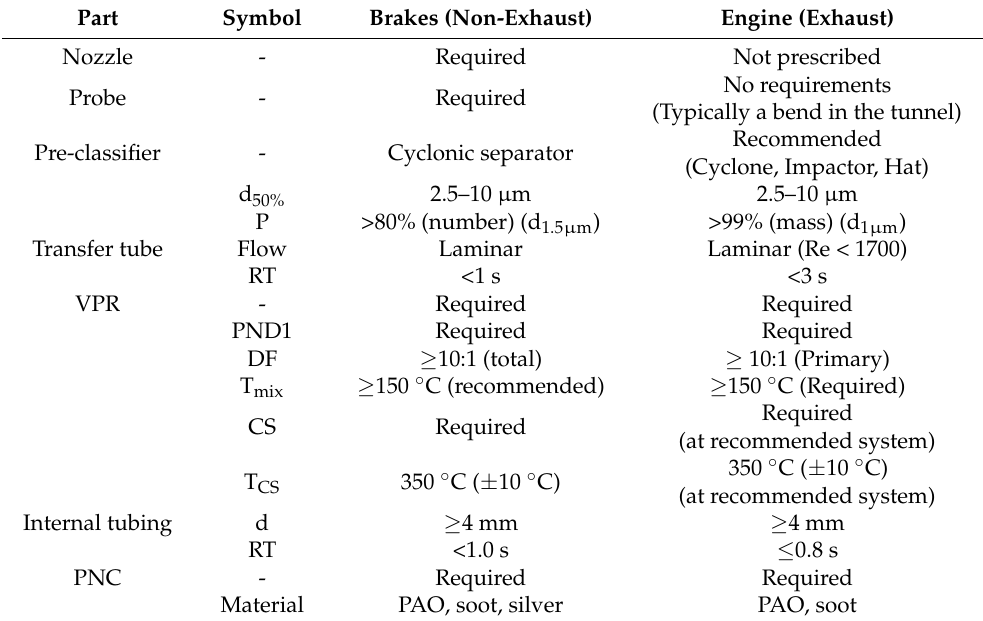
Table 4. Comparison of SPN 10 system requirements for vehicle brake and exhaust emissions. The table lists only the standard requirements for the brake and exhaust systems; the additional require- ments for the brake systems are in Figure